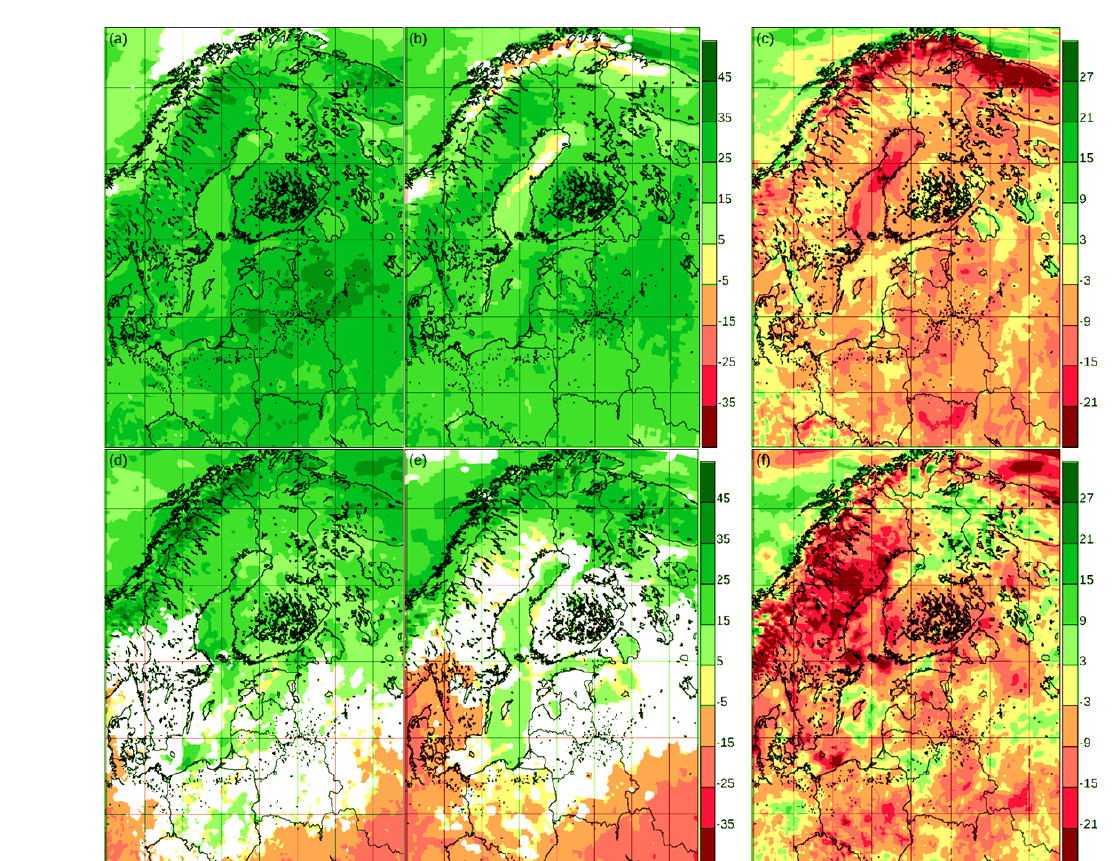
Figure 11. Precipitation relative change (%) between 1981–2010 and 2071–2100 for five atmosphere-only RCA4 simulations from EURO- CORDEX according to the RCP8.5 scenario (a, d) and for the coupled single-model RCA4-NEMO ensemble with the same driving GCMs (c, f) ; pointwise median values, only coloured when 75% of simulations agree on the sign of the change. Difference between the two ( c , f ; coupled minus uncoupled; %). (a–c) Winter; (d–f)